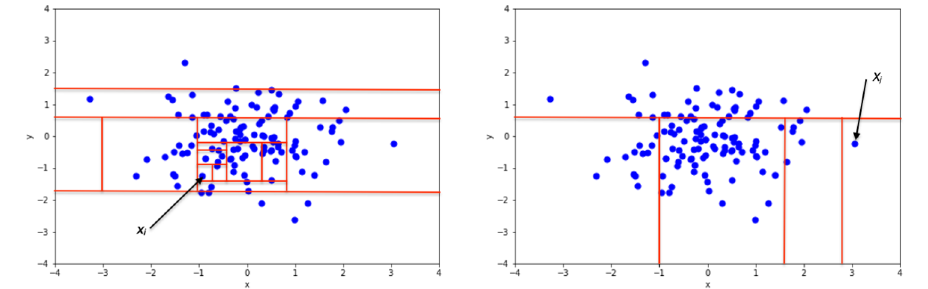
Figure 1 . An example of two trees formed in the IF algorithm for an arbitrary 2D Gaussian distribution. Left: the isolation of a non-anomalous data point, which has path length 13 . Right: the isolation of an anomalous data point, which has path length 4